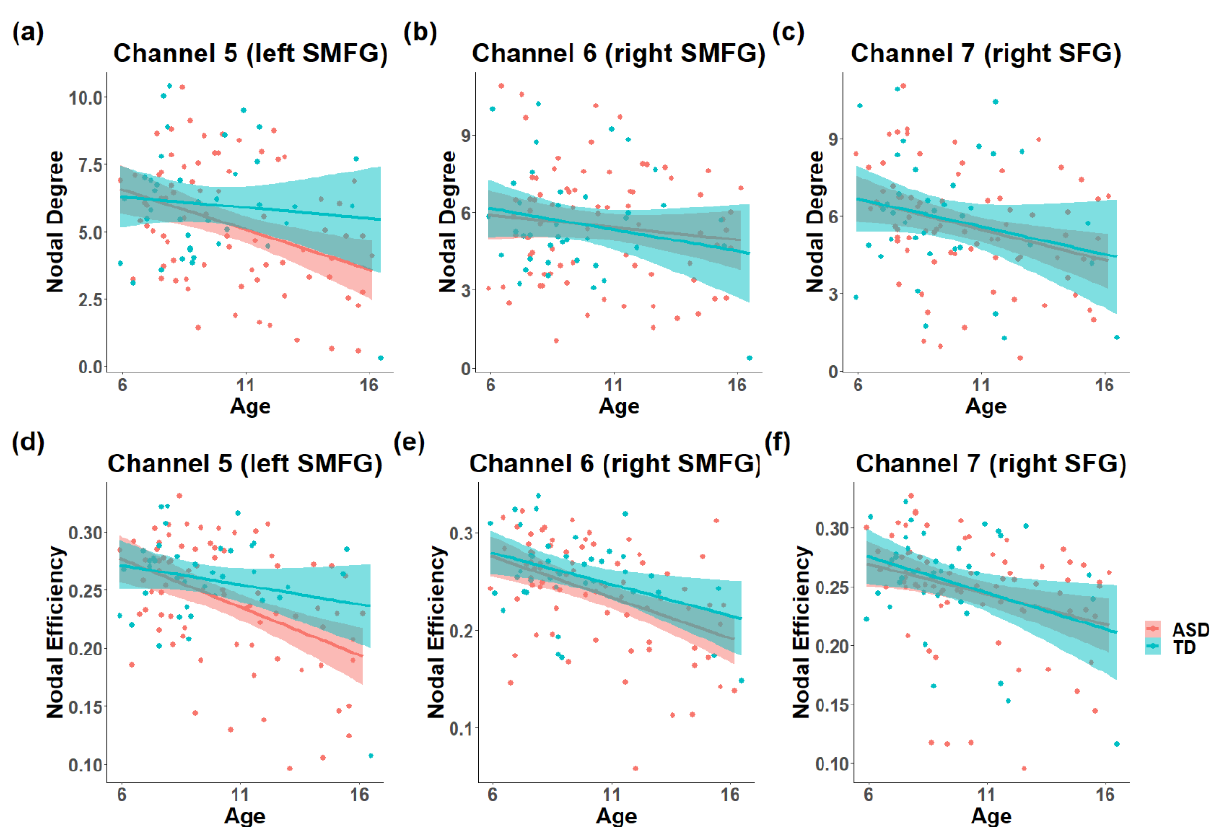
Figure 3. The plotted marginal effect curves of nodal metrics and age. TD participants showed an inverted U-shaped trajectory of the nodal degree ( a ) and nodal efficiency ( c ) in channel 3 in the left MFG, while participants with ASD showed U-shaped patterns. Furthermore, participants with ASD showed an age-related decrease in nodal degree ( b ) and nodal efficiency ( d ) in channel 10 in the right TPJ while the trajectory of TD was opposite.